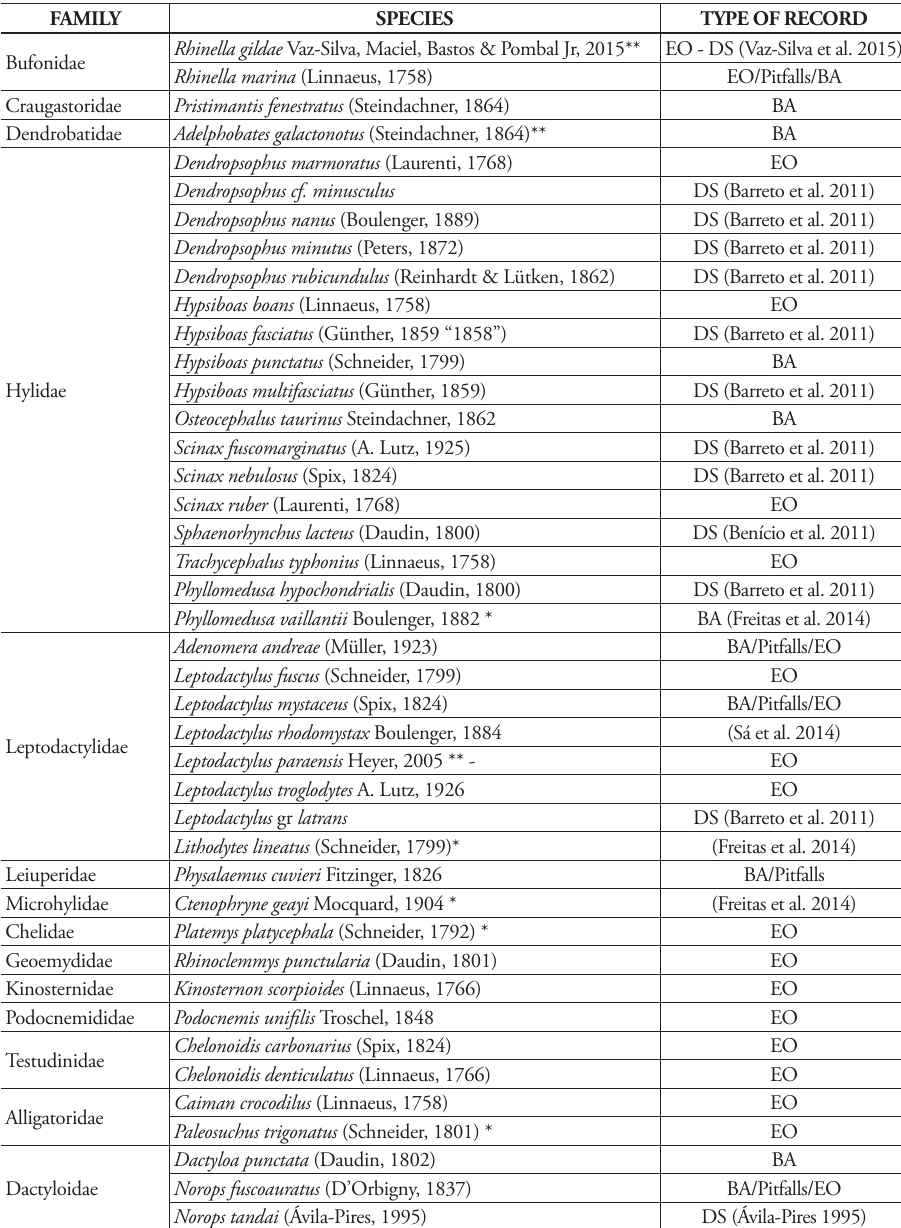
Table 1. Herpetofauna recorded between May 2012 and October 2013 in the Gurupi Biological Reserve, Maranhão, Brazil. (Type of record: EO = Opportunistic Encounter; BA = Constrained active search; Pit- falls = pitfall trap, DS = secondary data). * First occurrence for the state of Maranhão and northeast Brazil. ** Species endemic to the Belém center of